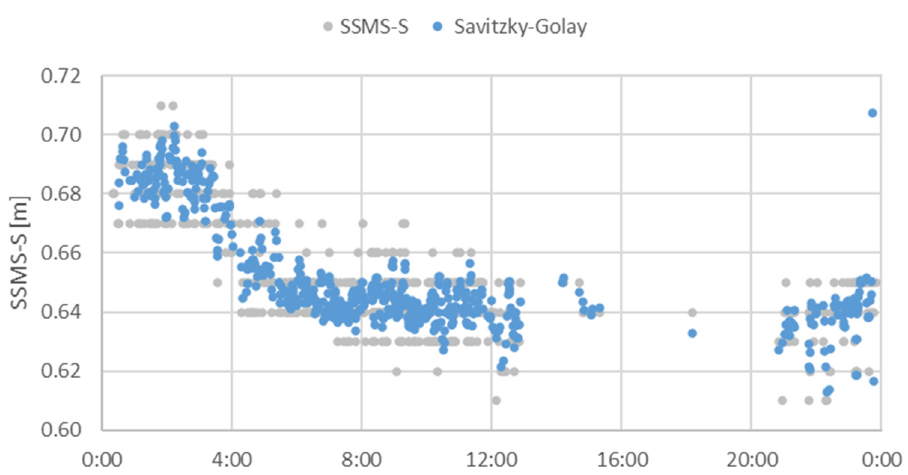
Figure 15. Roof support No. 59 pressure and tip to face distance (Savitzky–Golay method).